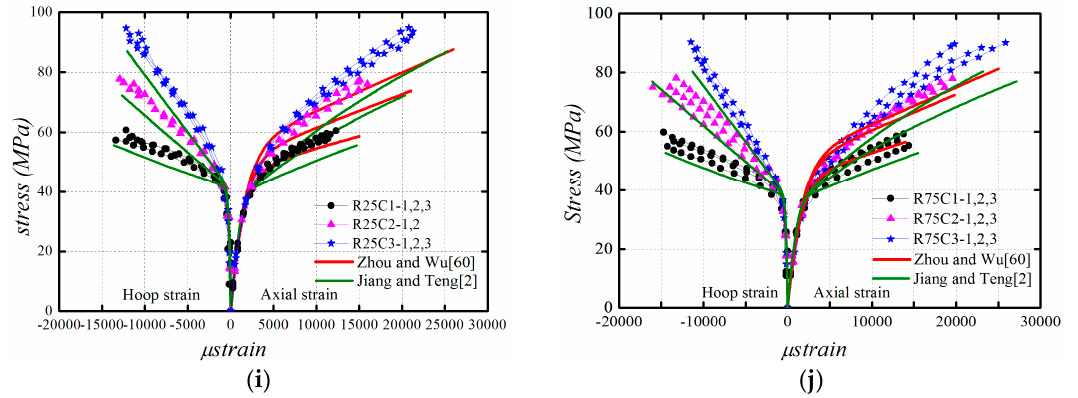
Figure 11. Model evaluations. ( a ) C1R0; ( b ) C2R50; ( c ) C1R100; ( d ) C2R100; ( e ) C3R100; ( f ) R0-G1~3 [51]; ( g ) R20-G1~3 [51]; ( h ) R100-G1~3 [51]; ( i ) R25 [52]; ( j ) R75